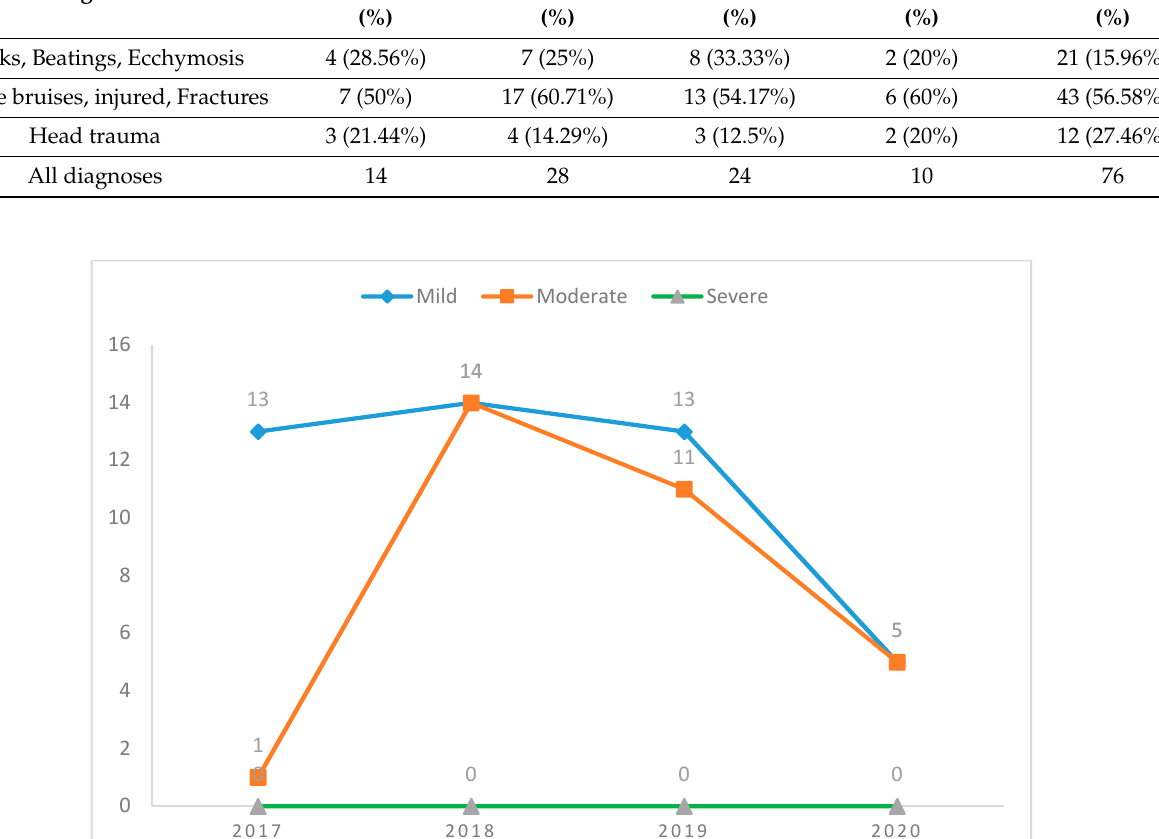
Figure 1. Time trend (2017–2020) of the number of cases of female violence that occurred over the years—in the periods corresponding to the lockdown (1 March–31 May of each year), divided according to their severity (mild, moderate or severe).